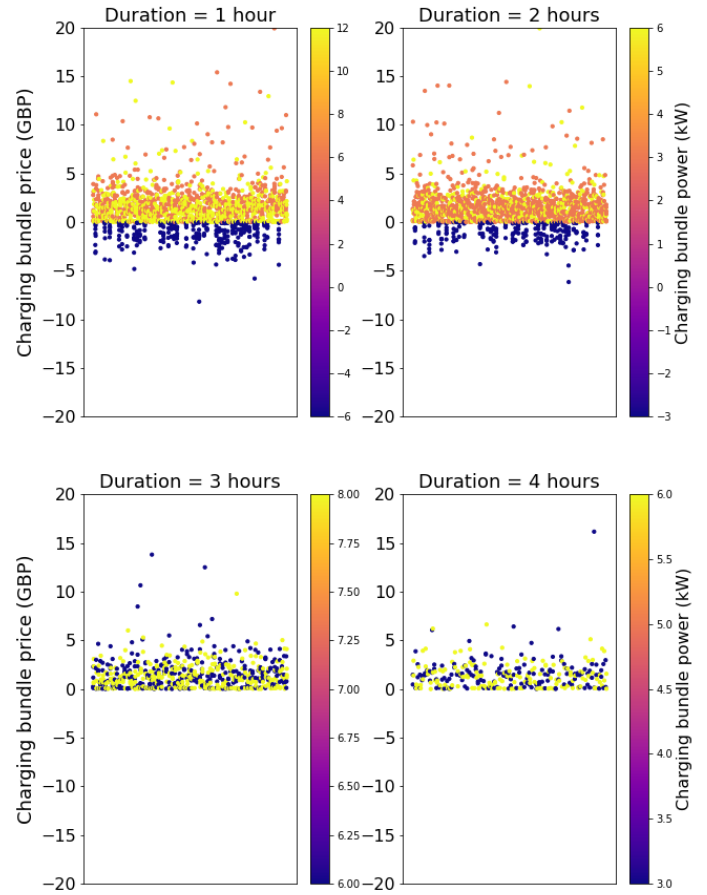
Figure 12. Classification of GA-optimized prices for charging and V2G bundles by power and charging duration.